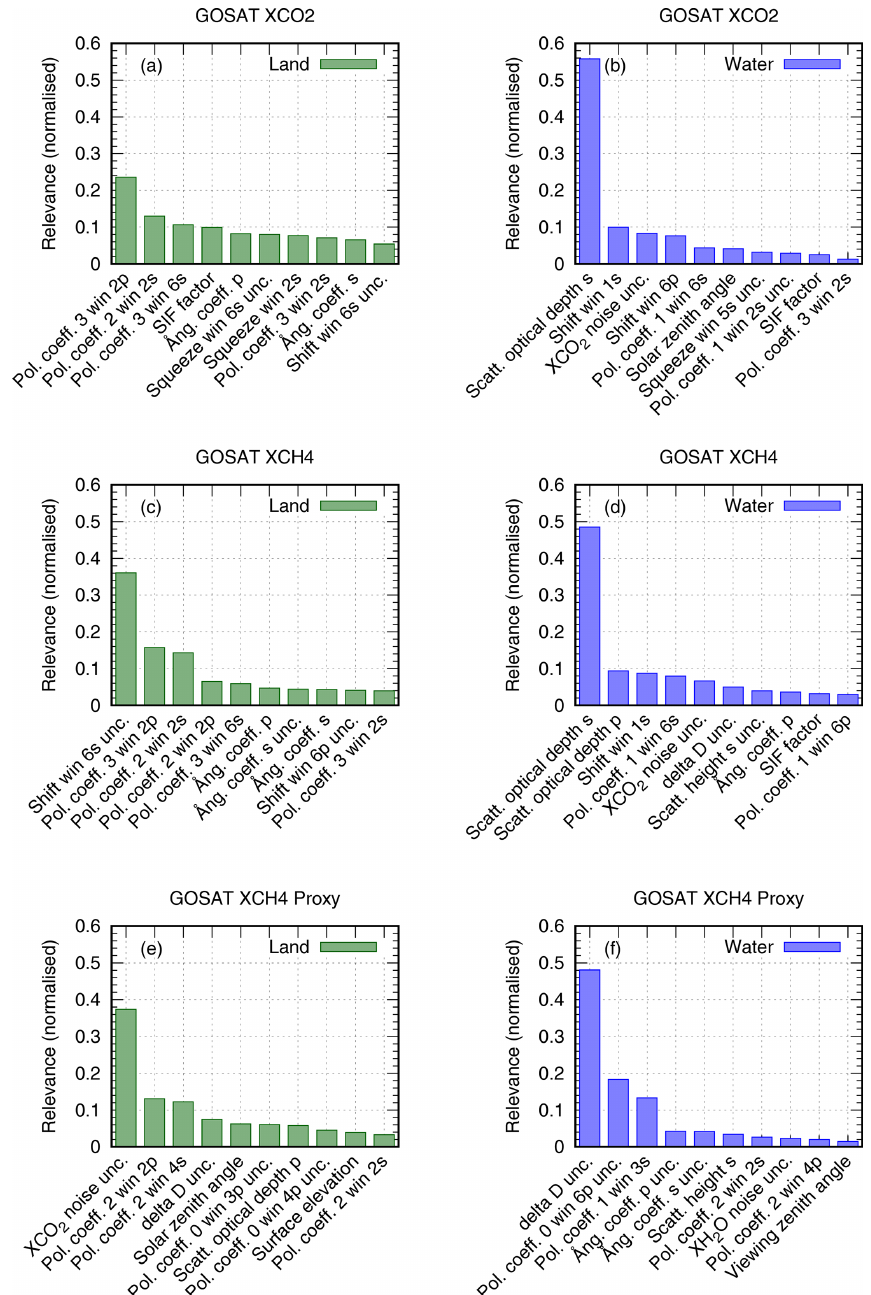
Figure A7. Variables selected for the GOSAT random forest bias correction and their relevance. (a, b) XCO 2 ; (c, d) XCH 4 ; (e, f) XCH 4 Proxy. Left and right columns are for land and water surfaces,